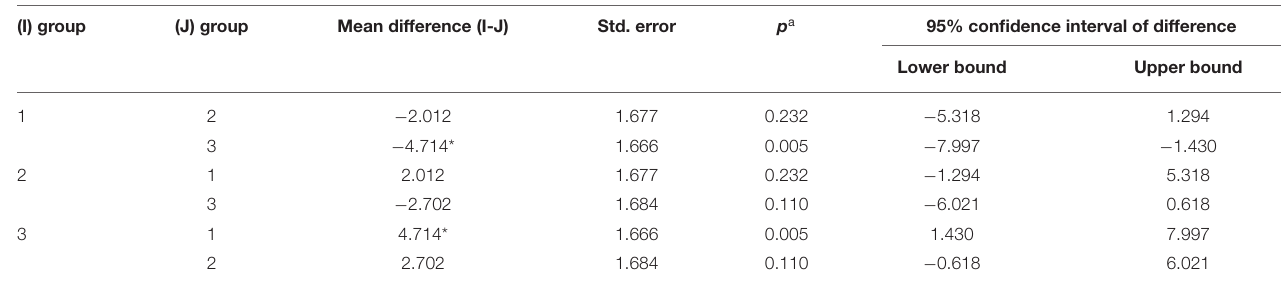
TABLE 4 | Pairwise comparisons at post-test writing